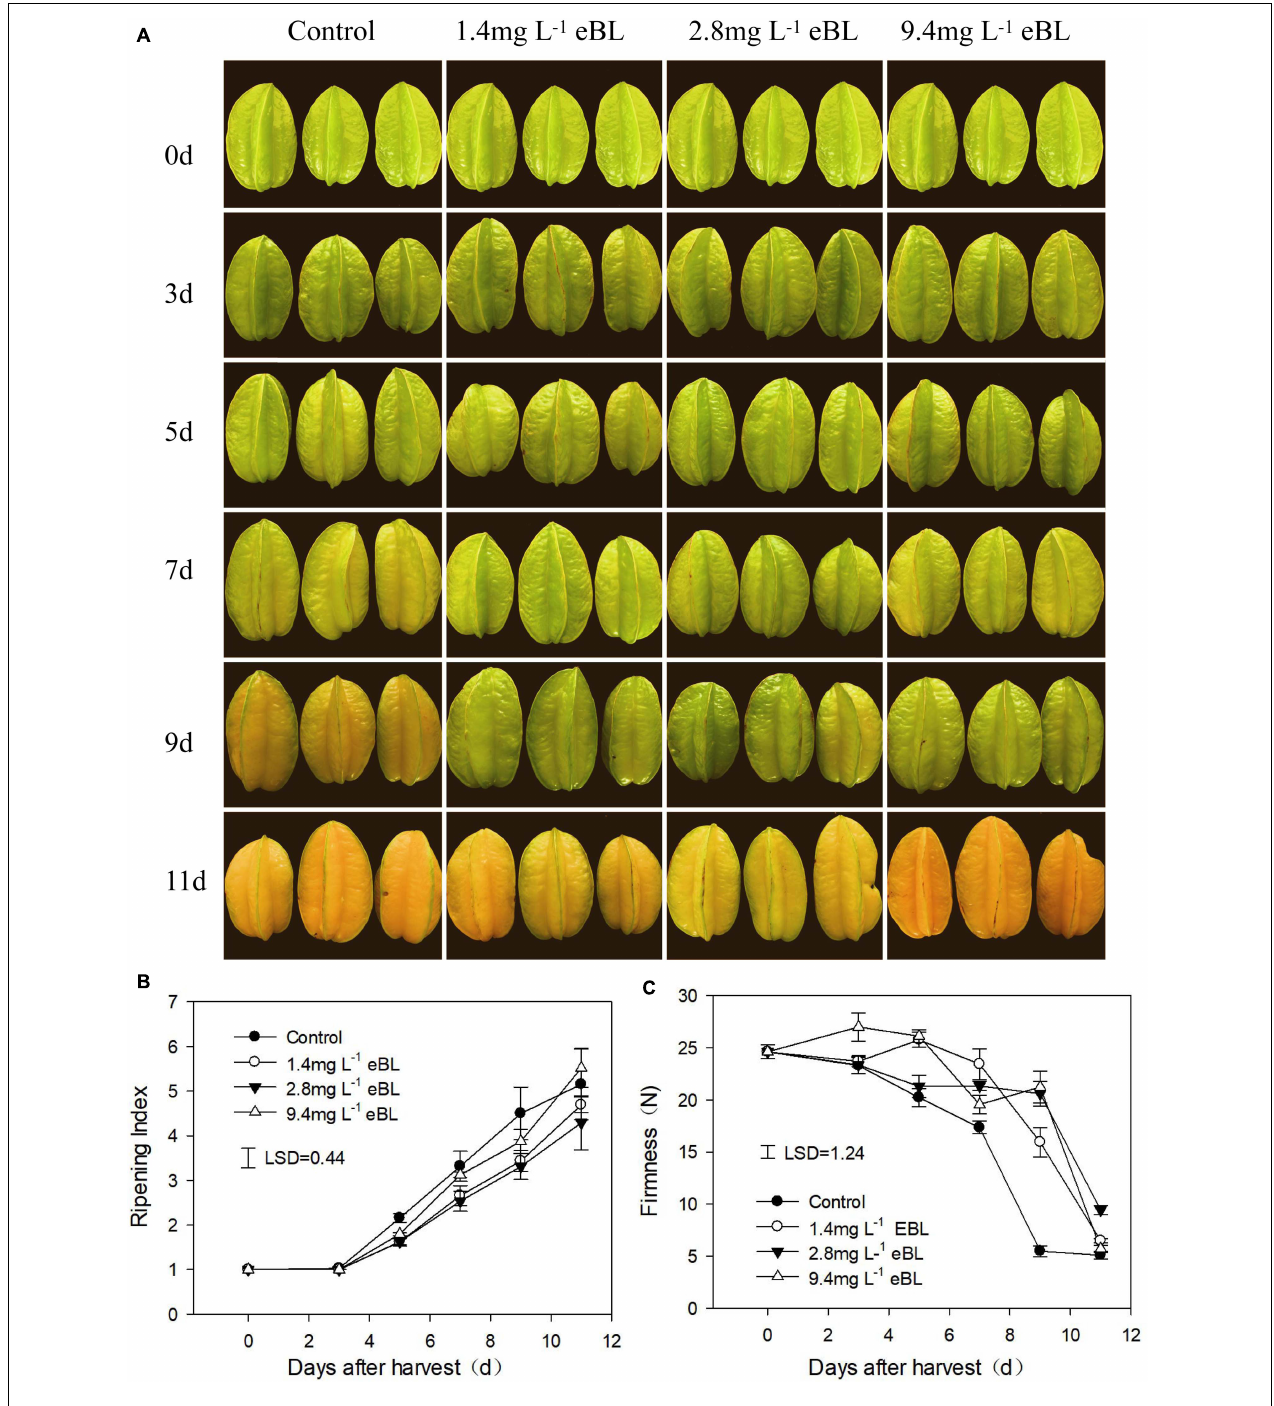
FIGURE 1 | The effects of different 2,4-epibrassinolide (eBL) concentrations on carambola fruit ripening. (A) Photos of carambola fruit treated with different concentration of eBL; (B,C) fruit ripening index (B) and firmness (C) under different treatments. Least significant differences (LSDs) were calculated to compare significant effects at the 5% level. Each data point represents the mean ± S.E. ( n = 3).